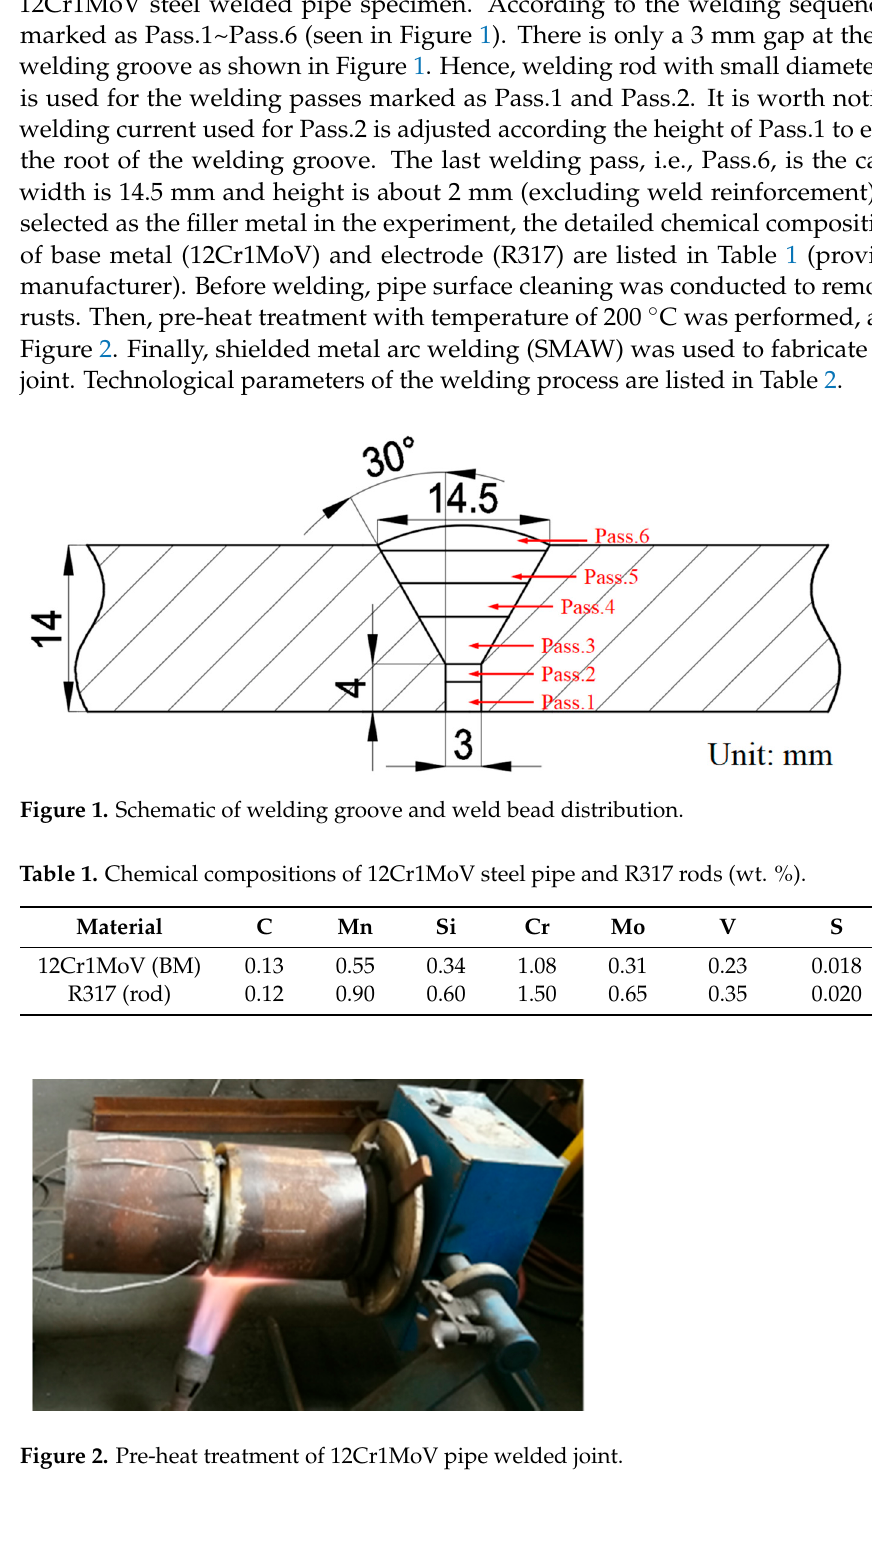
Table 1. Chemical compositions of 12Cr1MoV steel pipe and R317 rods (wt. %).